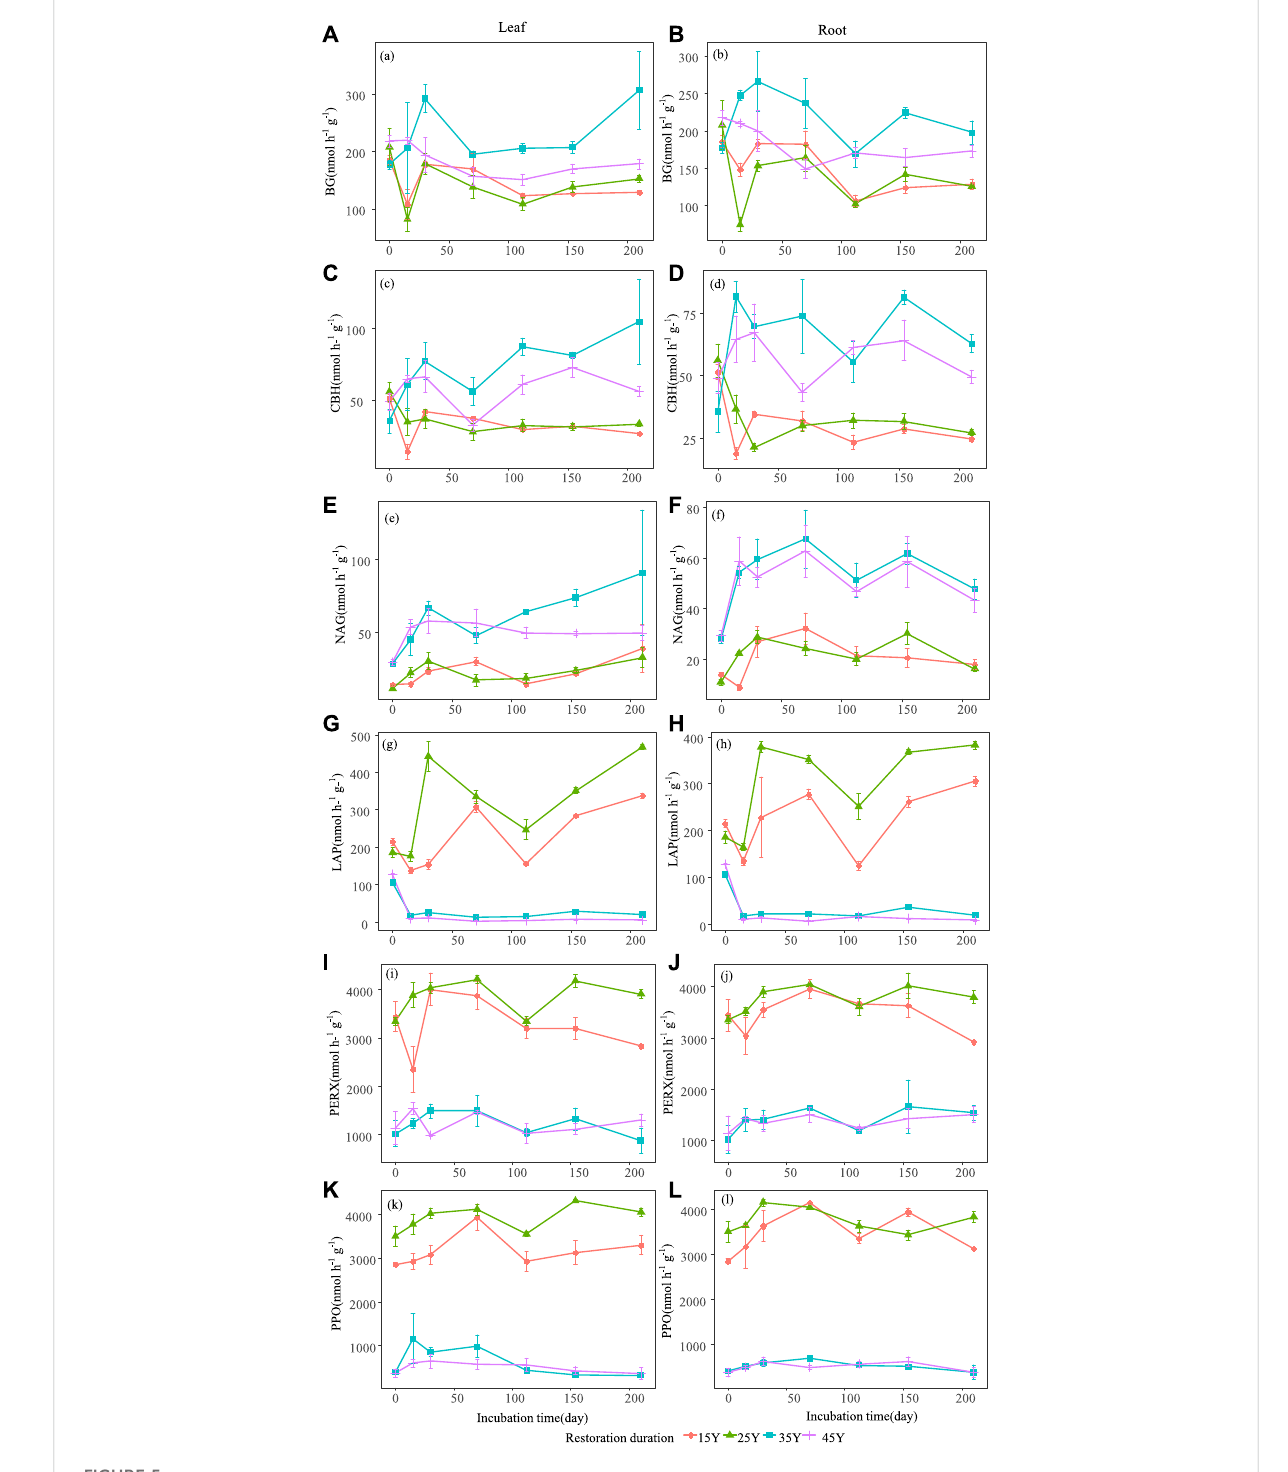
FIGURE 5 Temporaldynamicsofsoilenzymeactivitiesafter theleafandrootlitteradditioninfourdifferentrestoration durationsof Robinia pseudoacacia stands. Values are means ± standard error. The dynamic changes of soil β -1,4-glucosidase (BG) activity when leaf litter and root addition (A – B) ; the dynamic changes of soil cellobiohydrolase (CBH) activity when leaf litter and root addition (C – D) ; the dynamic changes of β -1,4-N- acetylglucosaminidase (NAG) activity when leaf litter and root addition (E – F) ; the dynamic changes of soil L-leucine aminopeptidase (LAP) activity when leaf litter and root addition (G – H) ; the dynamic changes of soilperoxidase (PERX) activity when leaf litter and root addition (I – J) ; the dynamic changes of soil phenol oxidase (PPO) activity when leaf litter and root addition (K – L)